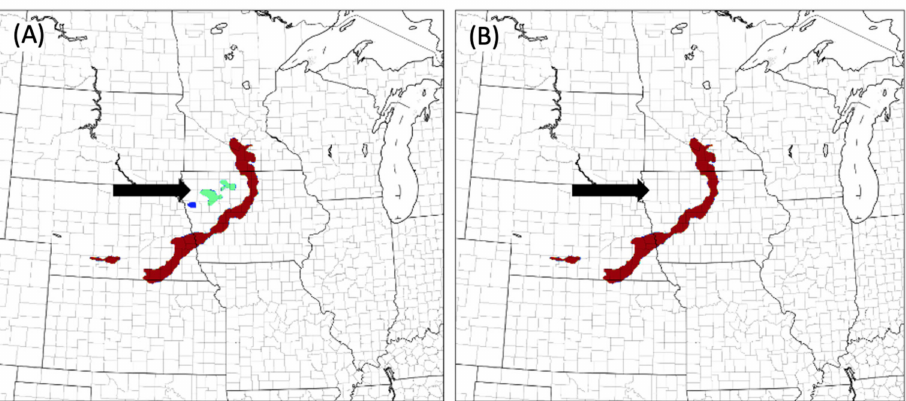
Figure 3. OBPROB observation object plots ( A ) before stratiform object filtering and ( B ) after stratiform object filtering. Observation object colors indicate convective scale category. Maroon objects correspond to meso-alpha or mesoscale organized convection, cyan objects represent meso- beta or multi-cell convection, and blue objects signify meso-gamma or single-cell